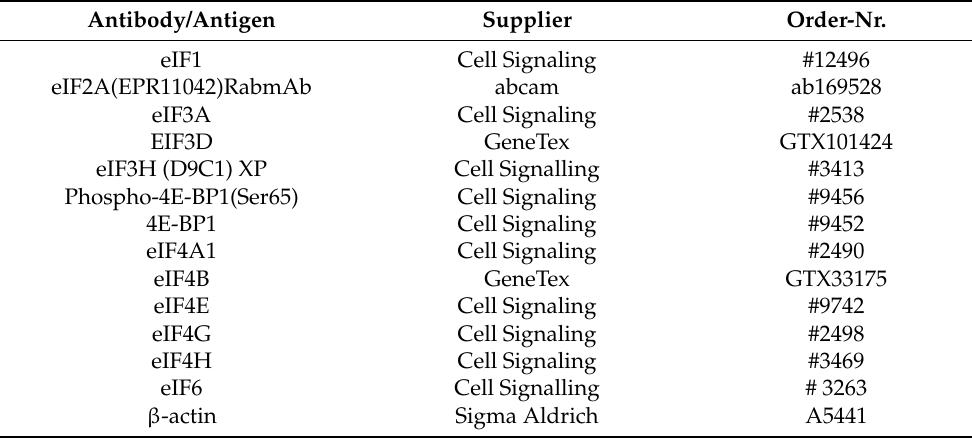
Table 1. Primary antibodies used in this study. Antibody/Antigen Supplier